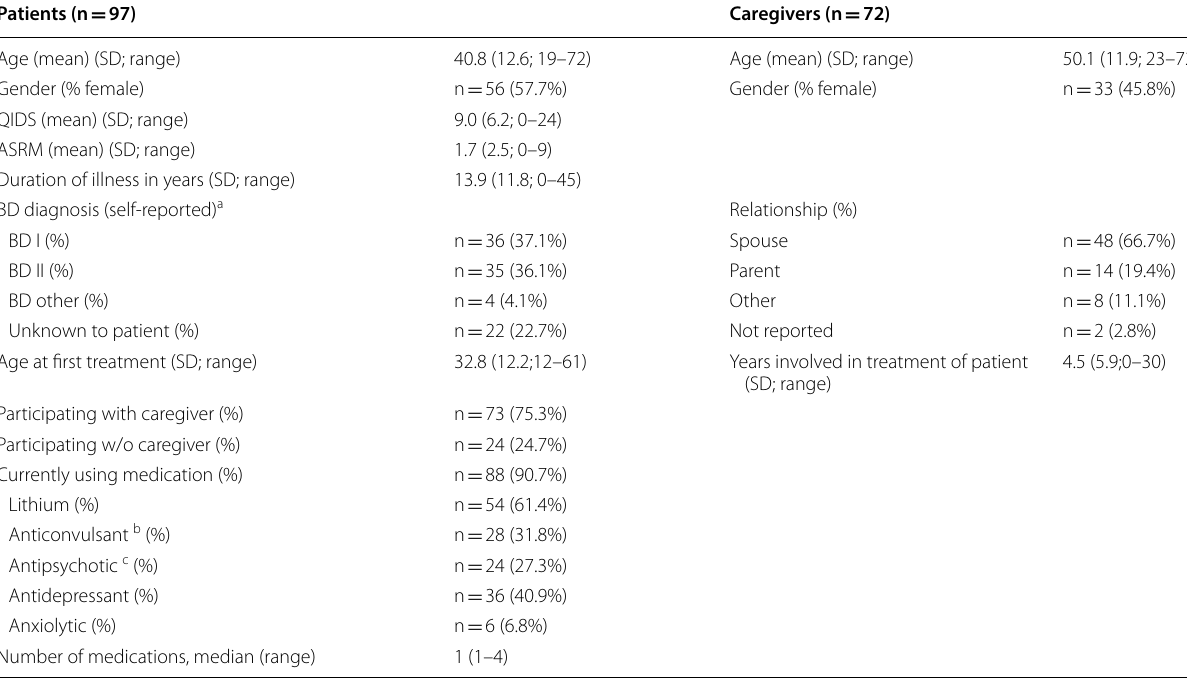
a Patients were asked about their diagnosis; before inclusion in the PE program, all patients had a clinically confirmed diagnosis of bipolar disorder type I, II or NOS b Anticonvulsants included valproate, lamotrigine, carbamazepine c Antipsychotics were mainly second generation